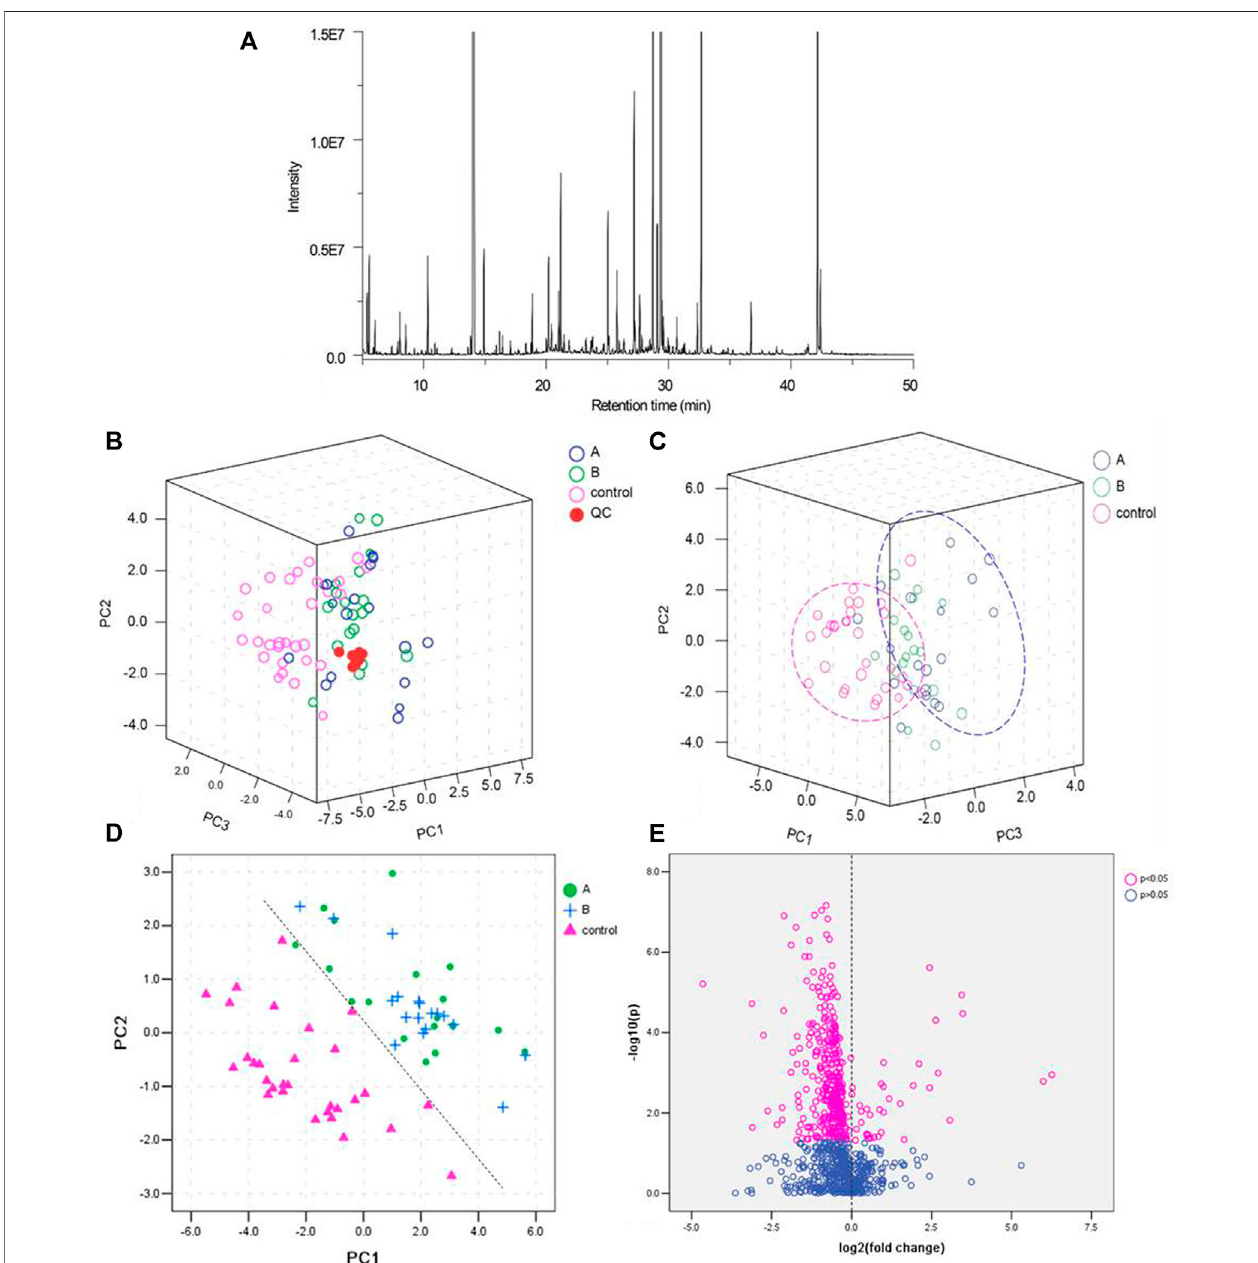
FIGURE 1 | Quality control (QC) of GC-MS analysis and partial least squares discriminant analysis (PLS-DA) of the urine samples. (A) : Total ion chromatograms (TICs) of the urine samples; (B) : PCA score scatter plots of QC samples from healthy subjects (control) and LDH patients (A with reality syndrome; B with de fi ciency syndrome); (C) : PCA score scatter plots of urine samples from healthy subjects (control) and LDH patients (A with reality syndrome; B with de fi ciency syndrome); (D) : PLS-DAscorescatterplotofurinesamplesfromhealthysubjects(control)andLDHpatients(Awithrealitysyndrome;Bwithde fi ciencysyndrome);and (E) :volcano plot of urine metabolites in healthy subjects and LDH